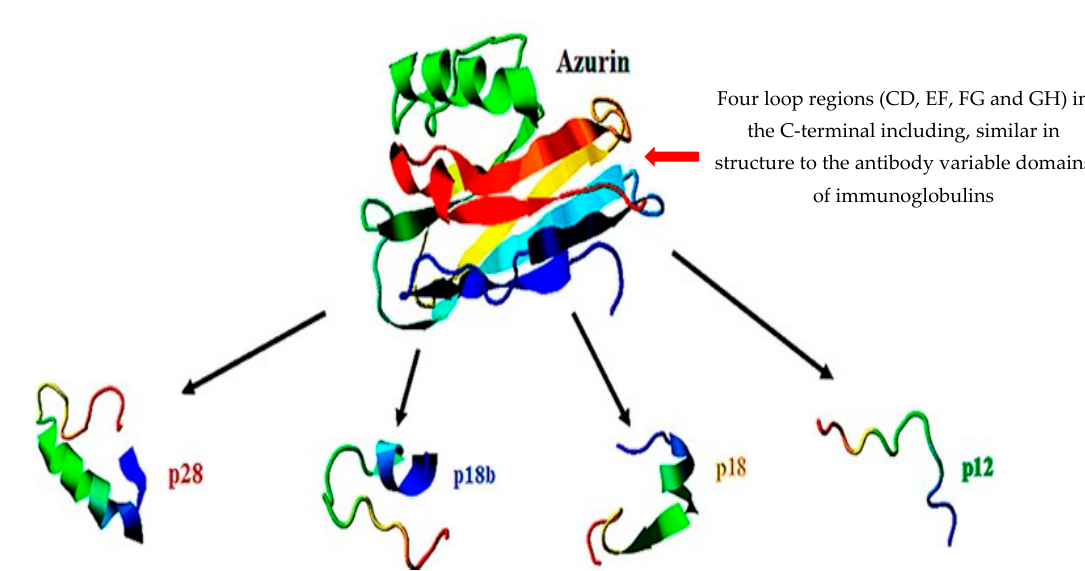
Figure 5. Azurin (128 amino acids), with an extended α -helix protein transduction domain, p28 (Leu50–Asp77), and four loop regions in its C-terminal (shown here in red, yellow, light blue and dark blue). The p28 peptide of 28 amino acids (amino acids 50 to 77) facilitates cell crossing and promotes apoptosis. Cell growth in tumours is repressed by 10 to 12 amino acids in the COOH terminal of p28. The α -helix, stretching over 18 amino acids (Leu 50 –Gly 67 ), shown here as peptide p18, has a high affinity for cancer cells (less so for normal cells), excellent penetration abilities, and high binding to the tumour repressor protein p53. Peptide p18b also contains 18 amino acids (Val 60 –Asp 77 ) but has a short α -helix and β -sheet and penetrates cancerous and normal cells. The p12 peptide of 12 amino acids (Gly 66 –Asp 77 ) does not have an α -helical structure, binds poorly to p35, and penetrates cancer and normal cells. Adapted from Yaghoubi et al. [317].